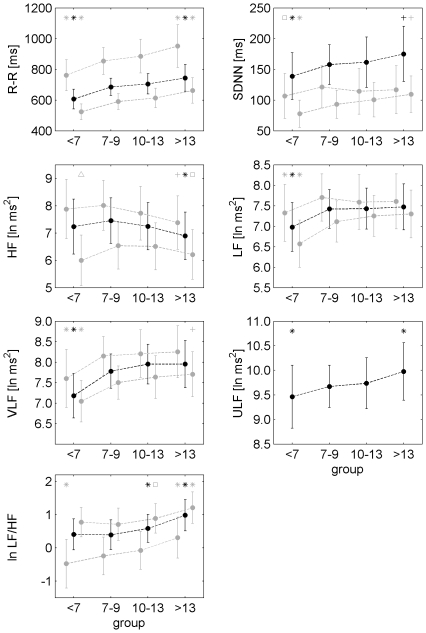
Comparison of different age groups with respect to time and frequency domain measures.R-R – mean R-R interval, SDNN – standard deviation of R-R interval series, HF – high frequency component, LF – low frequency component, VLF – very low frequency component, ULF – ultra low frequency component, ln ms2 – natural logarithm of the absolute values in ms2, ln LF/HF - natural logarithm of the ratio LF/HF. Each group shows three values: 24 h averages are plotted in black, night-time (left of black dot) and wake time averages (right of black dot) are plotted in grey. Note that ULF can only be calculated for the entire recording. The frequency domain measures were transformed by taking the natural logarithm to yield normal distributions (indicated by ‘ln ms2’). The symbol above a value/dot refers to comparisons within the same time period (24 h, night-time or wake time).* Group differed from 3 other groups. + Group differed from group <7 years and group 7 to 9 years. □ Group differed from group 7 to 9 years. ▵ Group differed from group 7 to 9 years and group 10 to 13 years.